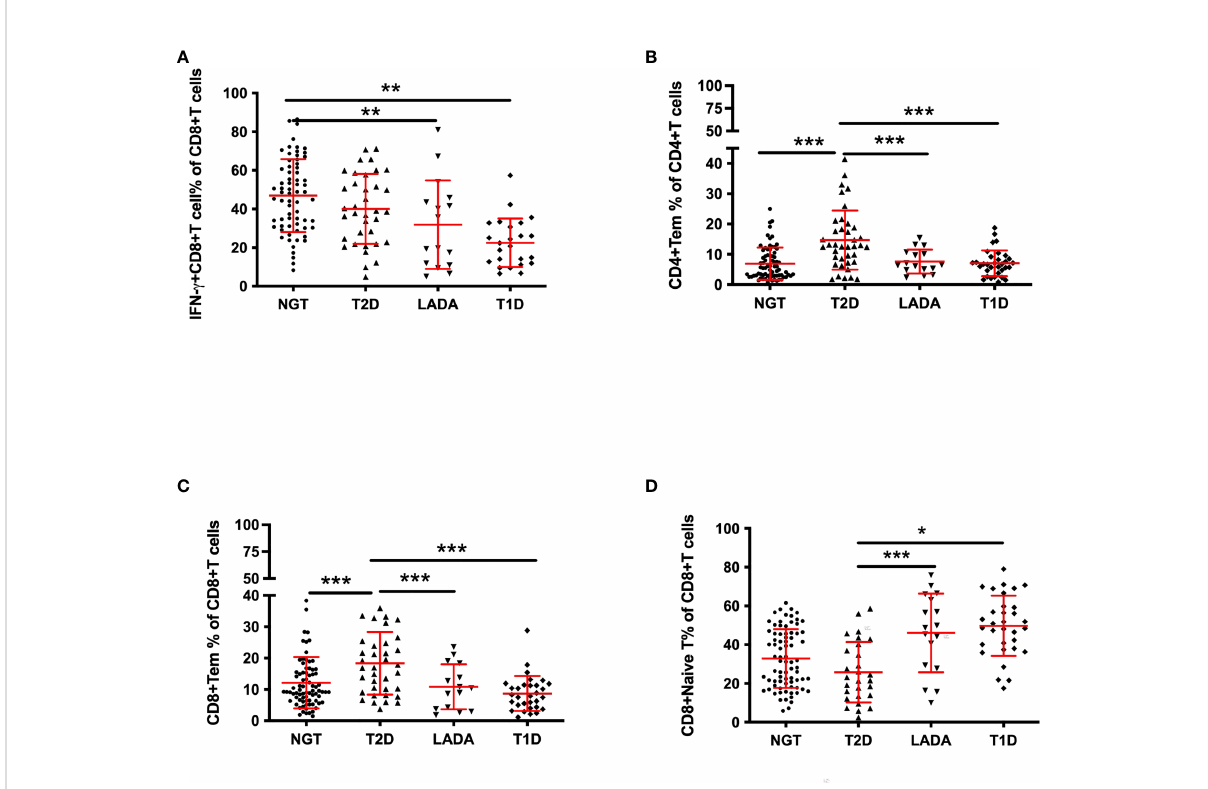
FIGURE 3 The frequency of peripheral T-cell subsets in new-onset diabetic patients and control subjects. The frequency of IFN- g + CD8 + T (A) cells gated on CD8 + T cells, CD4 + Tem cells (B) gated on CD4 + T cells, CD8 + Tem cells (C) gated on CD8 + T cells, and CD8 + naïve T cells (D) gated on CD8 + T cells in NGT subjects and new-onset T2DM, LADA and T1DM patients as determined by fl ow cytometry. P values refer to comparisons of data after adjustment for age and sex. Each point represents the percentage of T-cell subsets of an individual. Graphs show the median and interquartile range. *p<0.05, **p<0.01,